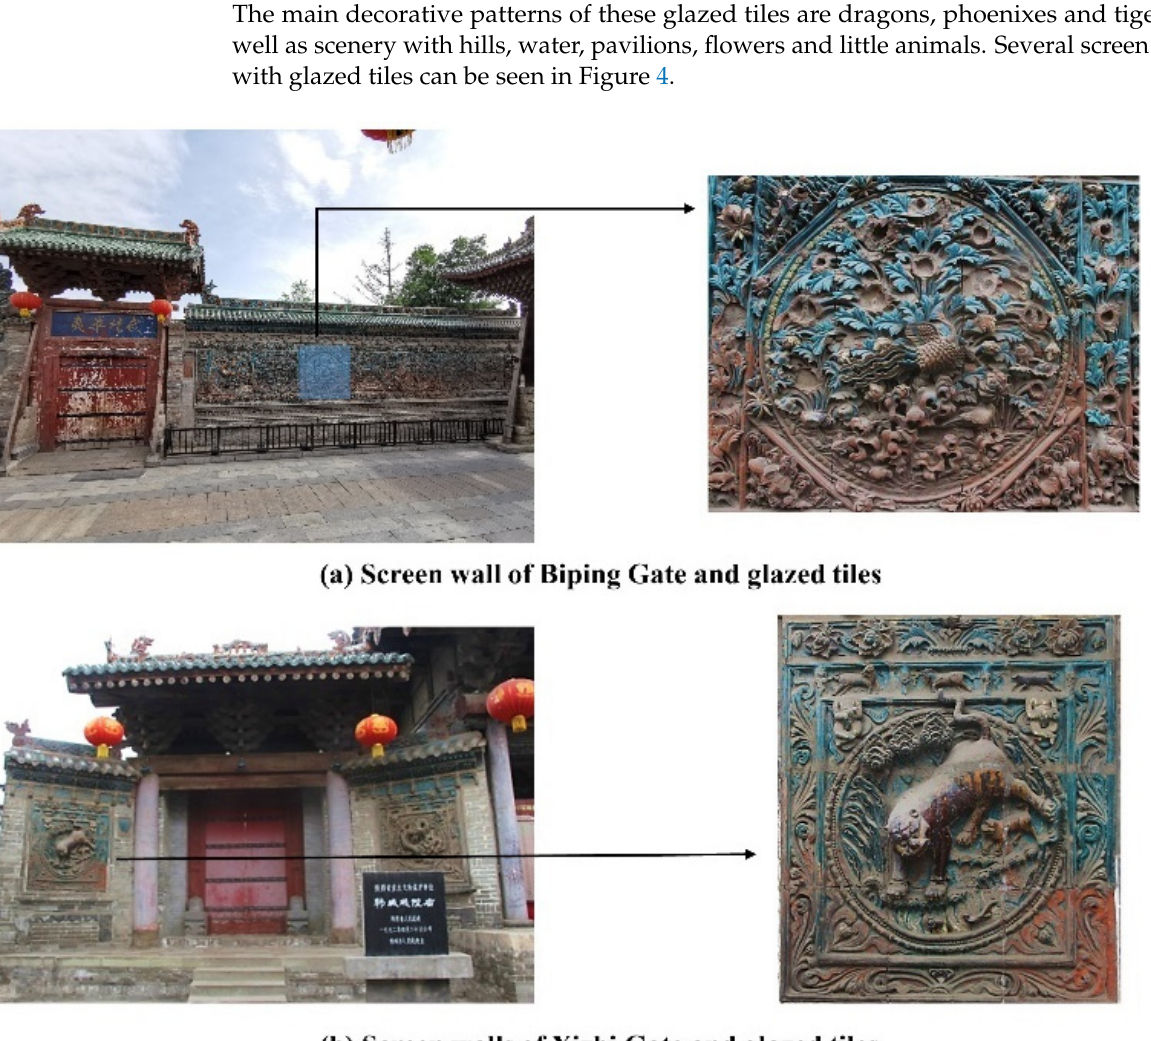
Figure 4. Screen walls with glazed tile decoration in the Hancheng Town God’s Temple building complex .